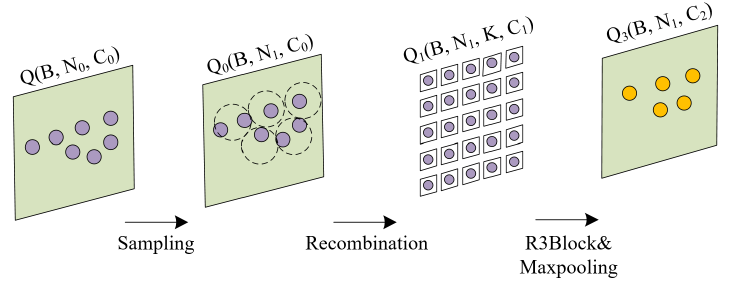
Figure 1. The MSA module structure. From left to right, the processing flow charts of Sampling layer, Recombination layer, R3Block layer, and Maxpooling layer are in